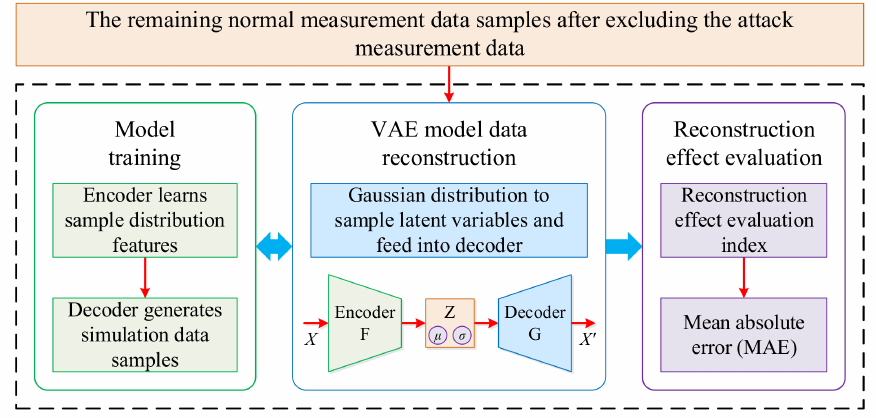
Figure 7. FDIA data reconstruction